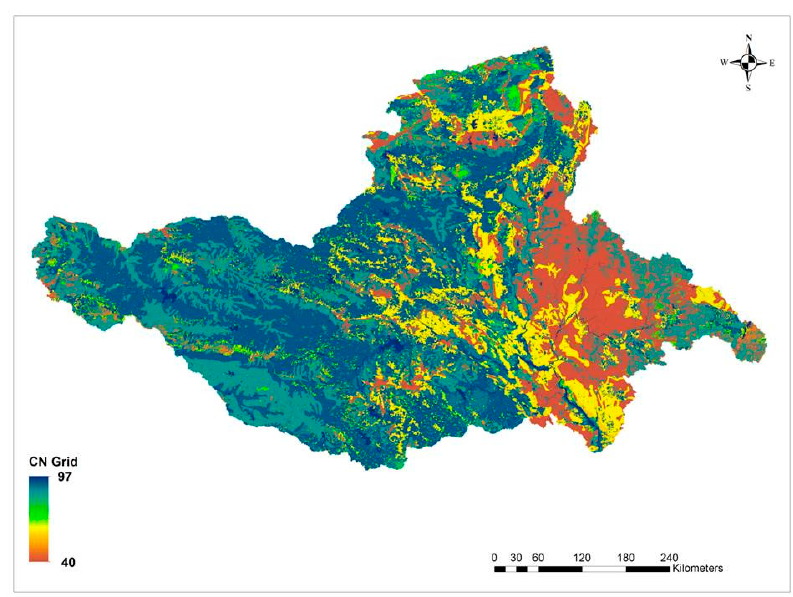
Figure 6. Hydrological soil group map of the study area.